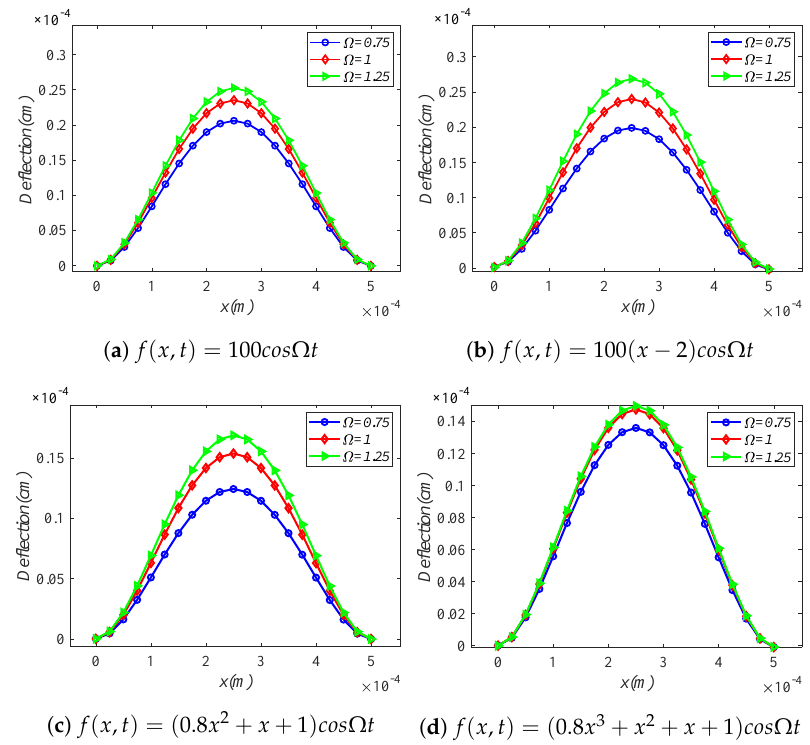
Figure 5. Deflection of the micro-beam under different simple harmonic